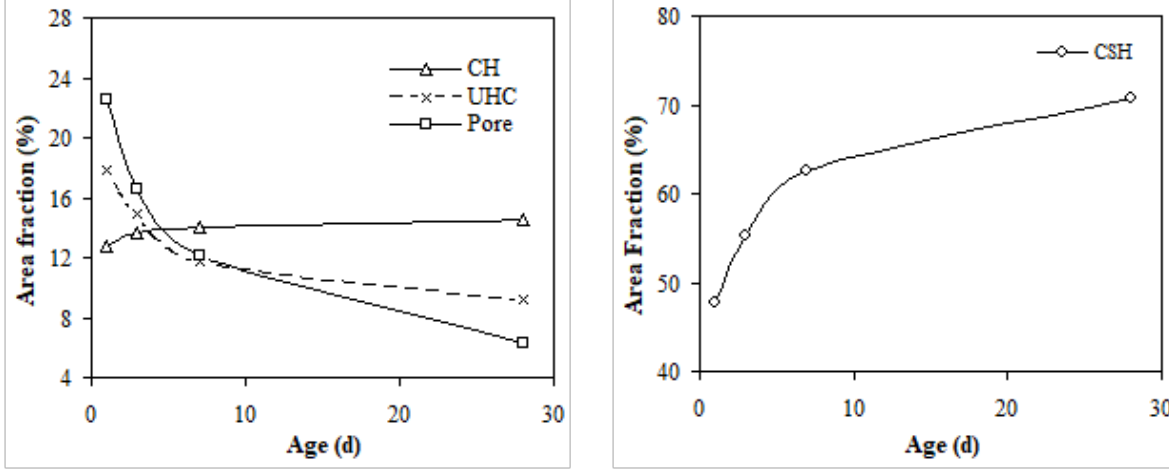
Figure 1: Area fractions of different phases from SEM measurements. CH is calcium hydroxides. UHC is unhydrated cement and CSH is calcium silicate hydrates.